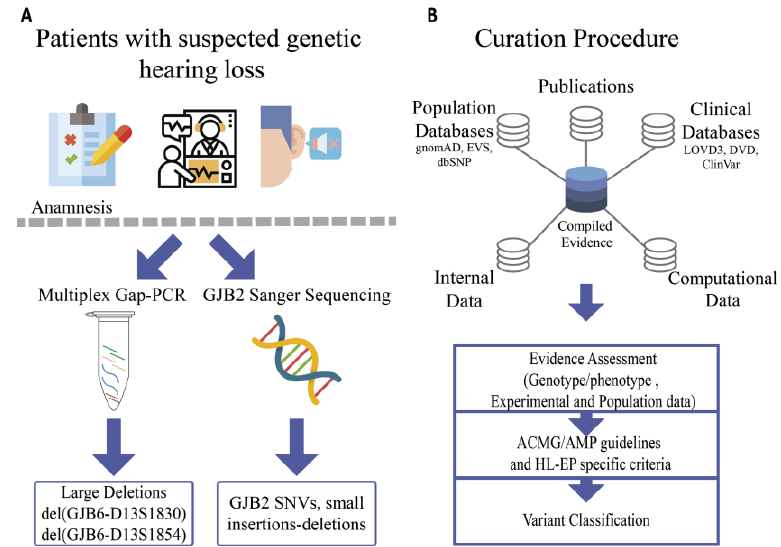
Figure 1. General workflow of this study. ( A ): Molecular screening of patients. Some icons were obtained from flaticon webpage [68]. ( B ): Variant curation process.